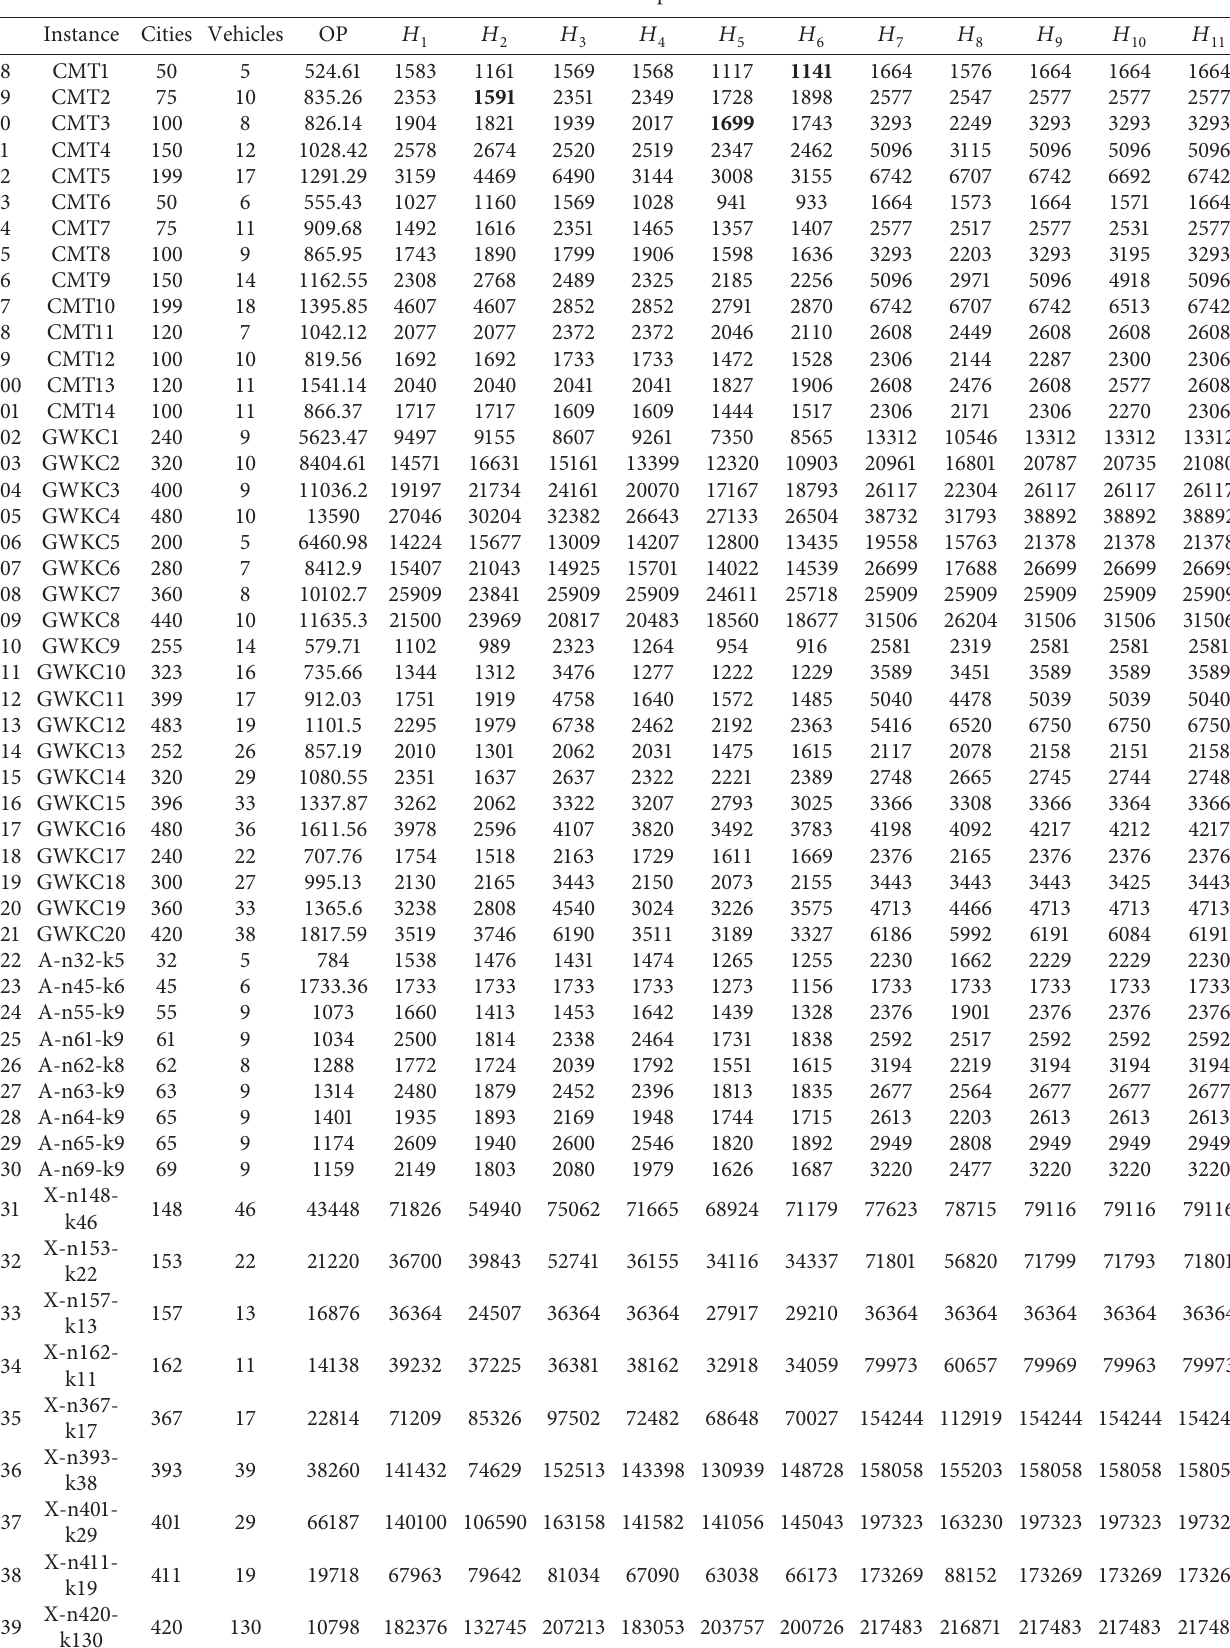
Table 9: Results for CVRP-capacitated